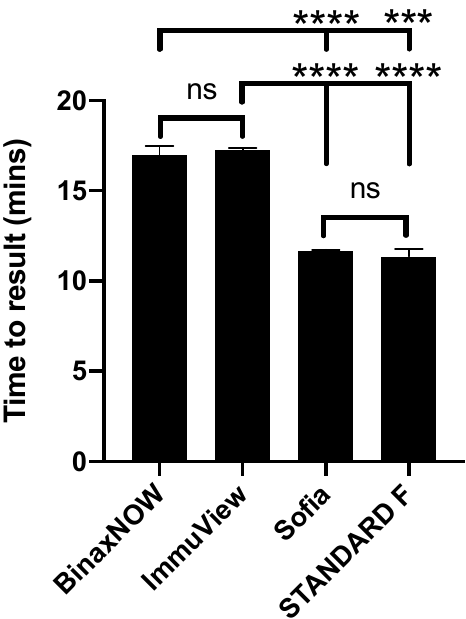
Figure 4. Time to result for four Streptococcus pneumoniae urine antigen tests. (*** p ≤ 0.001; **** p ≤ 0.0001).